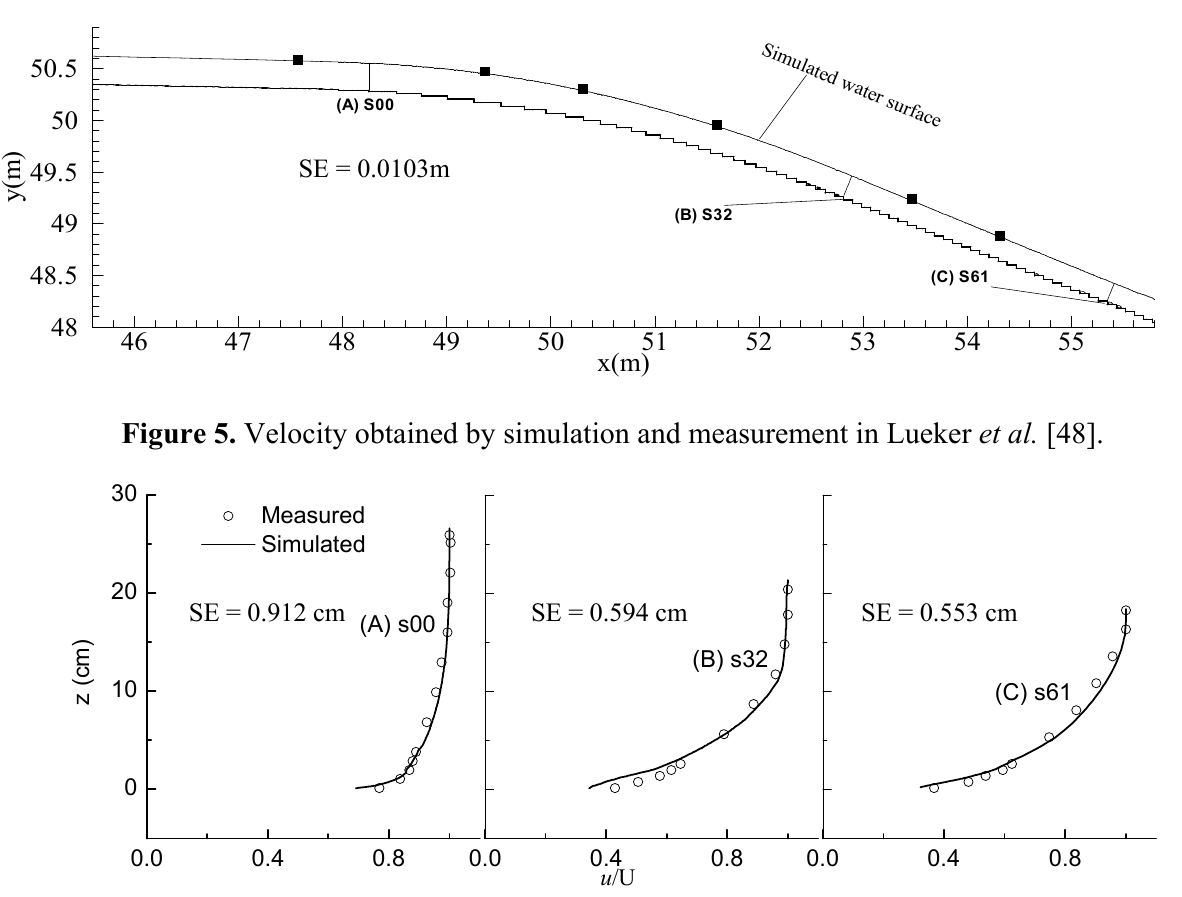
Figure 4. Water surfaces obtained by simulation and measurement in Lueker et al. [48].